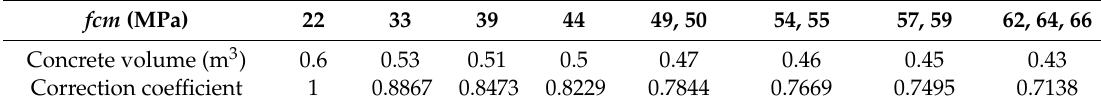
Table 4. Results of the frame sections